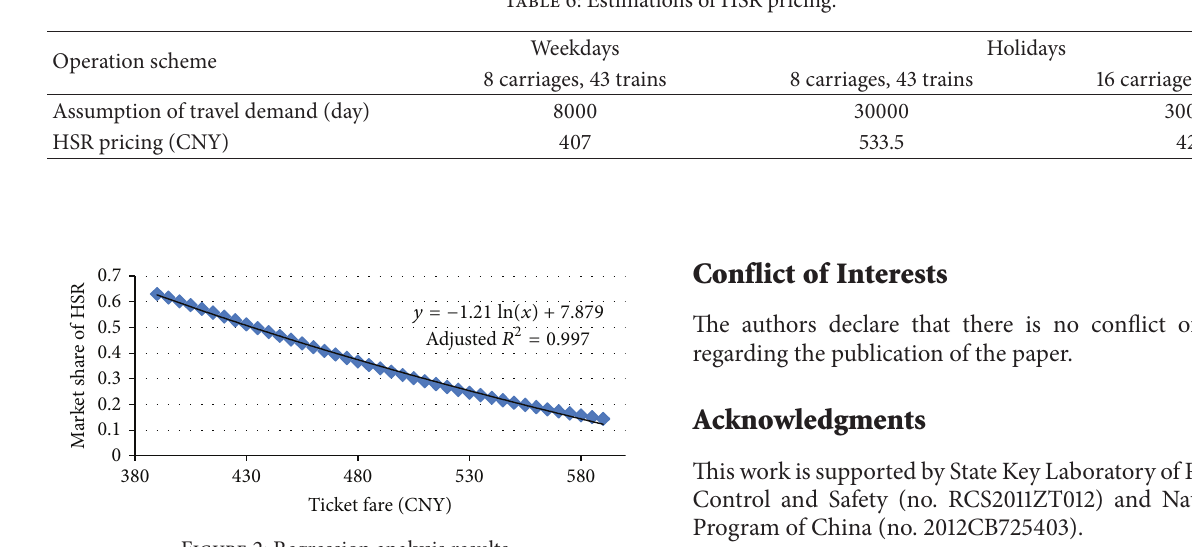
Figure 2: Regression analysis